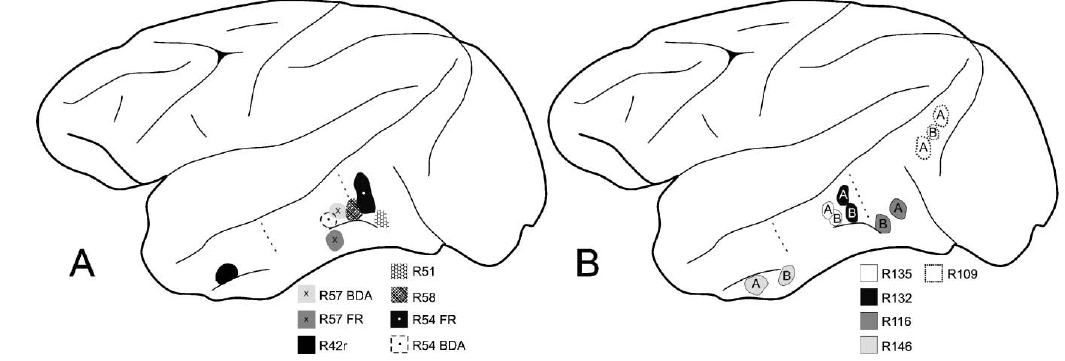
Figure 1. Schematic diagrams of the macaque left cerebral hemisphere to demonstrate location of tracer injections . ( A ) Five cases with injections of BDA, or BDA and FR, in anterior TE, posterior TE, or TEO. Dotted lines indicate estimated borders for these three regions (Saleem and Logothetis, 2007). ( B ) Five cases with injections of BDA (“B”) and AdSynEGFP (“A”) in anterior TE, posterior TE, TEO, or V4 (case 109).